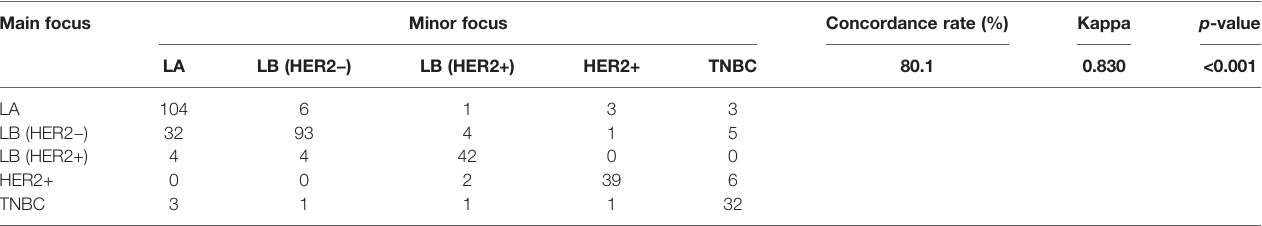
TABLE 3 | Concordance rates of molecular subtypes a